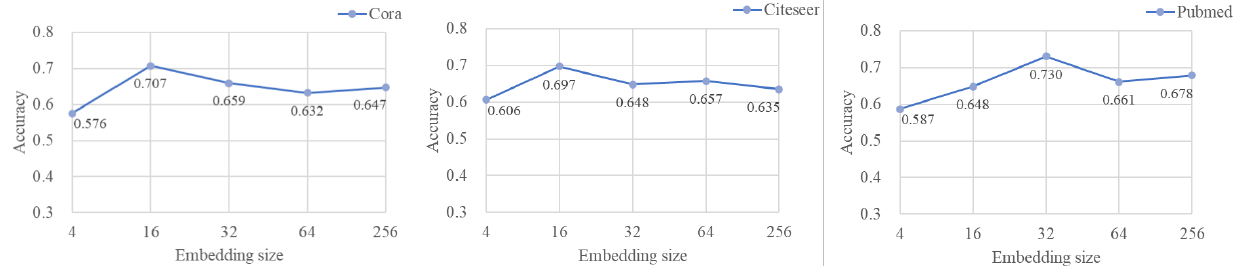
Figure 4. Analysis for embedding